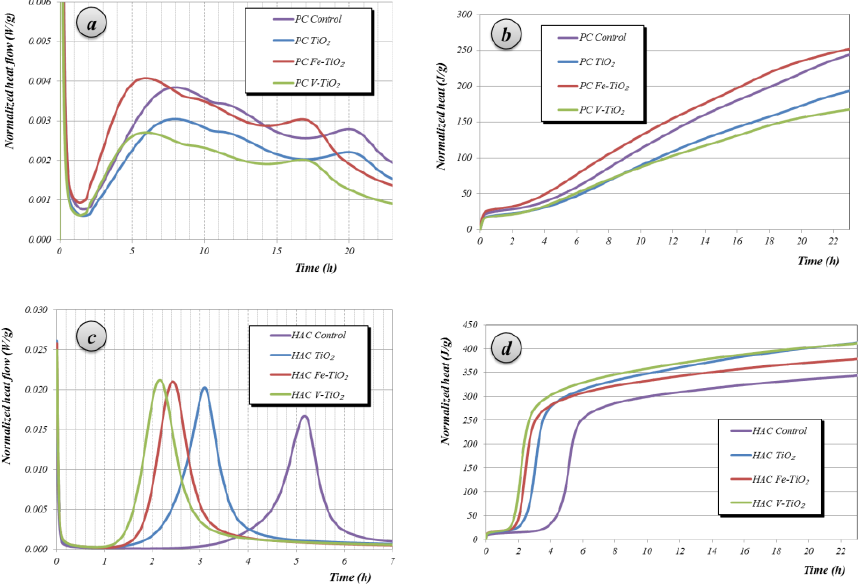
Figure 4. Isothermal calorimetry curves: ( a , c ) normalized heat flow and ( b , d ) total heat release of PC and HAC pastes with 2.5 wt. % of additives as compared with control (additive-free) sample.